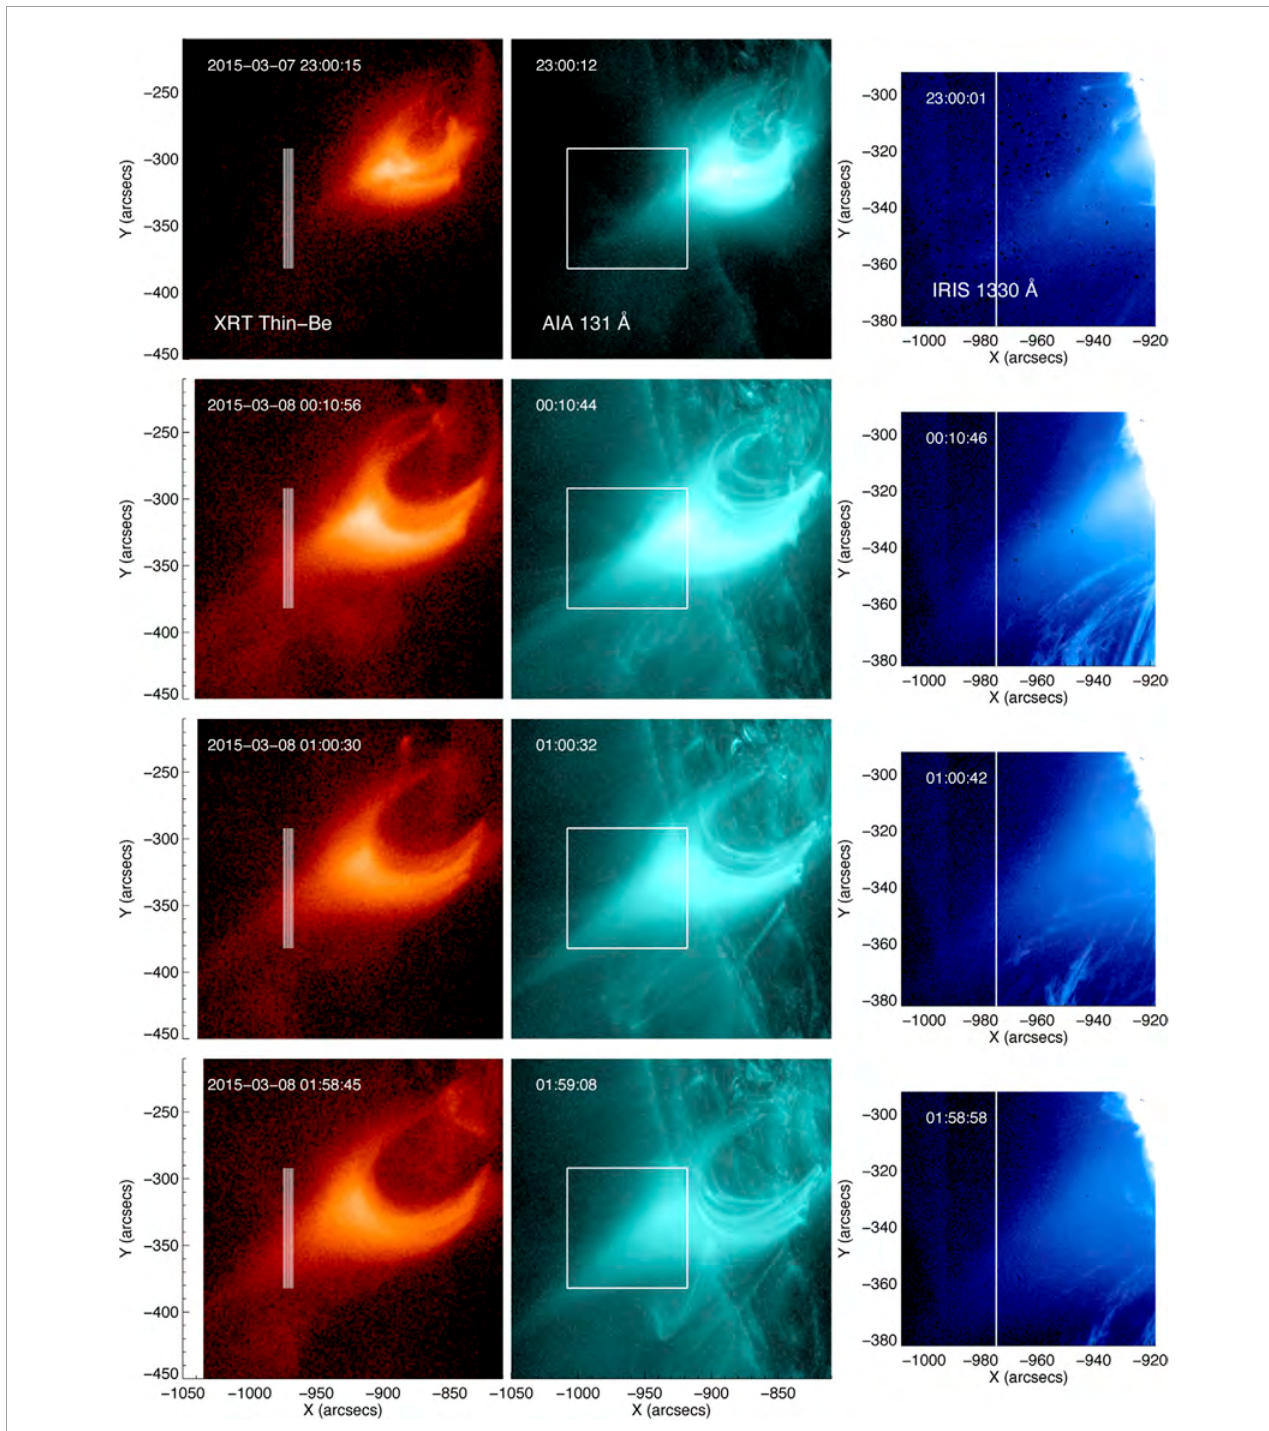
FIGURE 1 Overview of the 2015–03-07 flare between 23:00:15 UT to 01:58:45 UT on March 8th. The panels from left to right are observed images from Hinode /XRT, SDO /AIA 131Å, and IRIS 1330 Å SJI. The vertical white lines on XRT images indicate the slit position of IRIS Fe XXI spectra observations. The white box on AIA 131 maps shows the SJI